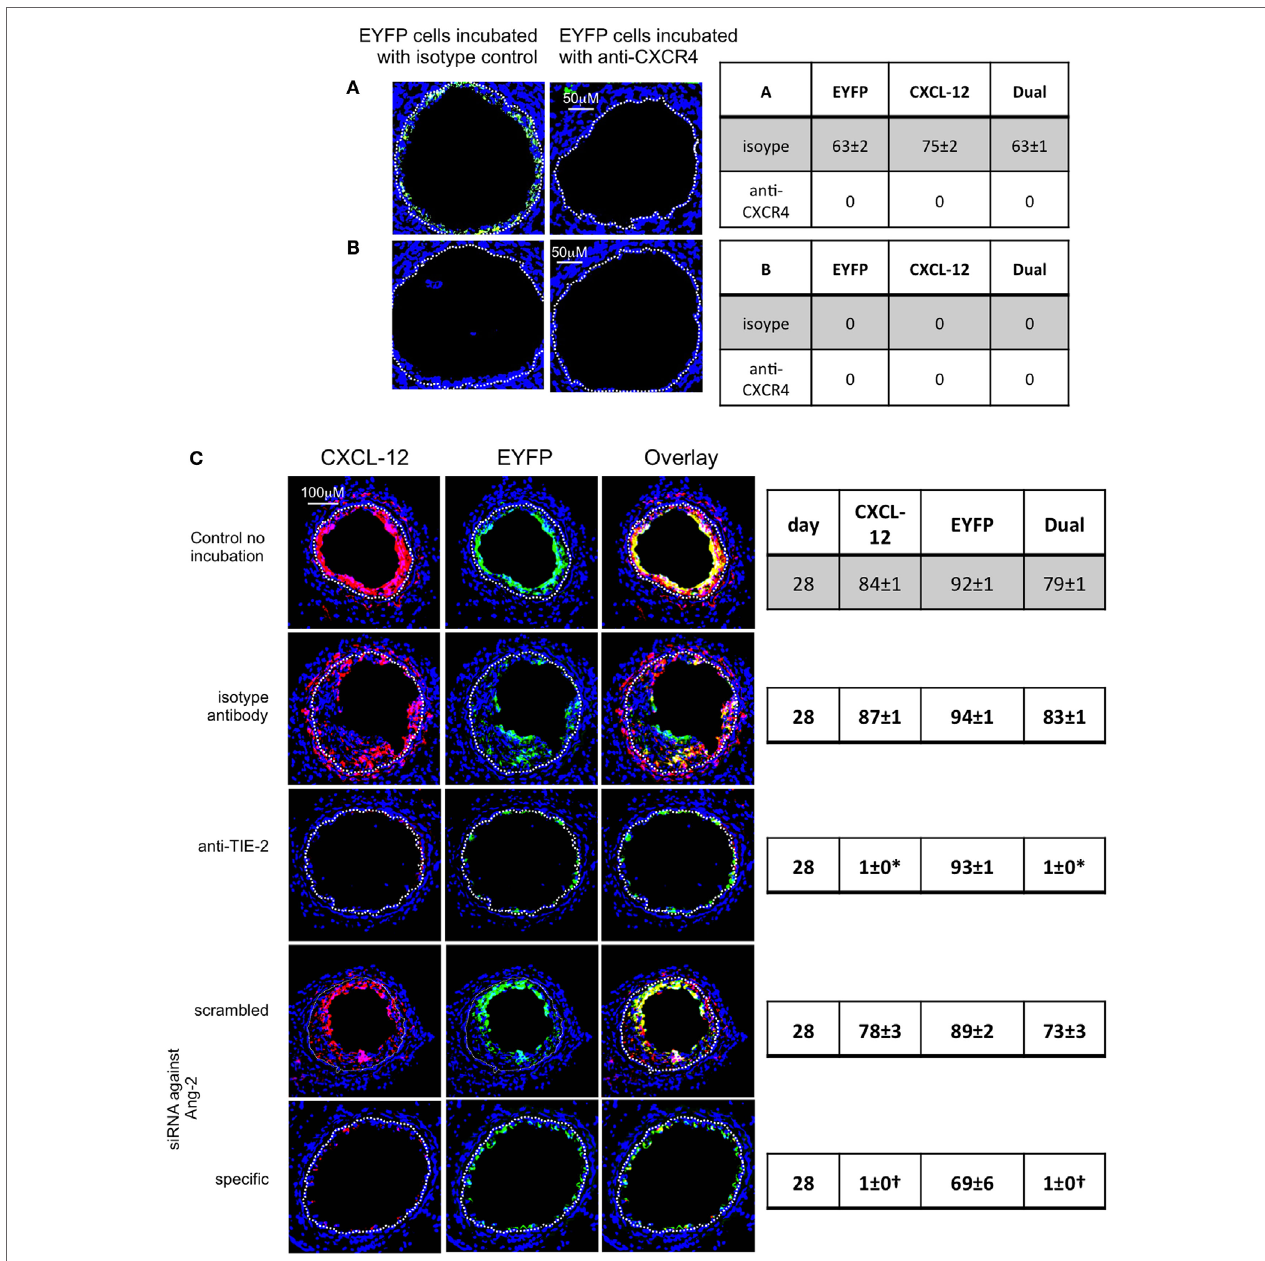
FigUre 12 | Pre-incubation of enhanced yellow fluorescent protein (EYFP) CD34 + cells with reagents to target CXCR4 or angiopoietin-2 prior to adoptive transfer. Panels show immunohistology of consecutive sections through injured mouse carotid arteries harvested on day 28 post-injury. All sections stained with DAPI (4,6 diamidino-2-phenylindole) nuclear stain (blue) and anti-CXCL-12 (red). The green staining is light emitted by the EYFP cells themselves. Yellow indicates co-localization. The annotated white line defines the junction between neointima and media. (a,B) Injured wild-type (WT) mice were adoptively transferred with CD34 + cells on day of injury. In (a) , the cells came from WT mice. In (B) , the cells came from CD31-TFPI-Tg mice. 1 week later, both groups of mice received a second adoptive transfer of EYFP CD34 + cells that were pre-incubated with either isotype control antibody or anti-CXCR4 as indicated. Sections were harvested 1 week later (day 14 post-injury). The annotated white line defines the junction between neointima and media. The anti-CXCR4 prevented late recruitment of adoptively transferred CD34 + cells in (a) , but in (B) , there is no late recruitment of adoptively transferred EYFP cells, even those pre-incubated with control antibody. (c) Adoptive transfer of EYFP CD34 + cells to injured WT mice at the time of injury. Cells first incubated with an anti-TIE-2 or isotype control, or siRNA targeting angiopoietin-2 or scrambled control. Compared to the control cells and those incubated with isotype control antibody, the anti-TIE-2 antibody significantly reduced the neointimal area but did not inhibit angiopoietin-2 expression. Compared to the scrambled siRNA, the specific siRNA targeting angiopoietin-2 significantly reduced the neointimal area in association with abolition of angiopoietin-2 expression cells. Tables besides panels describe summary of staining from all mice ( n = 6), showing the proportion of the neointimal area that is positive for CXCL-12, EYFP, or both on day of examination (% ± SEM). Data derived from three random sections from each of the arteries from each mouse (see Materials and Methods). *cf isotype for anti-TIE-2 p < 0.001. † cf scrambled siRNA p < 0.001. Experiments repeated at least twice.